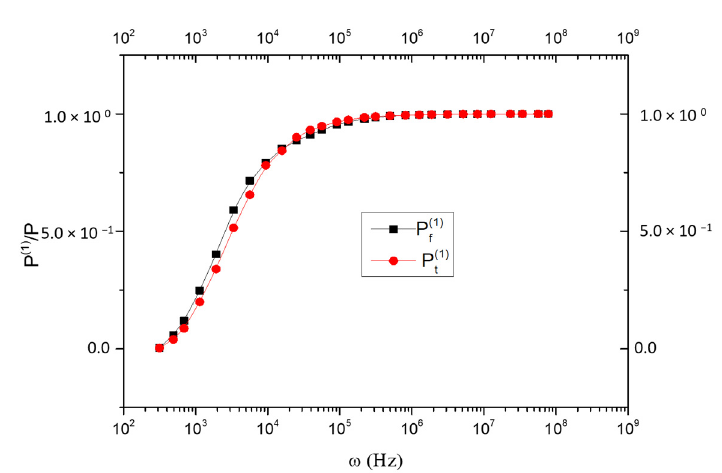
Figure 1. Comparison between normal (black line) and cancerous cells (red line) orientation polarization P (1) values as a function of frequency, see equation (A23).